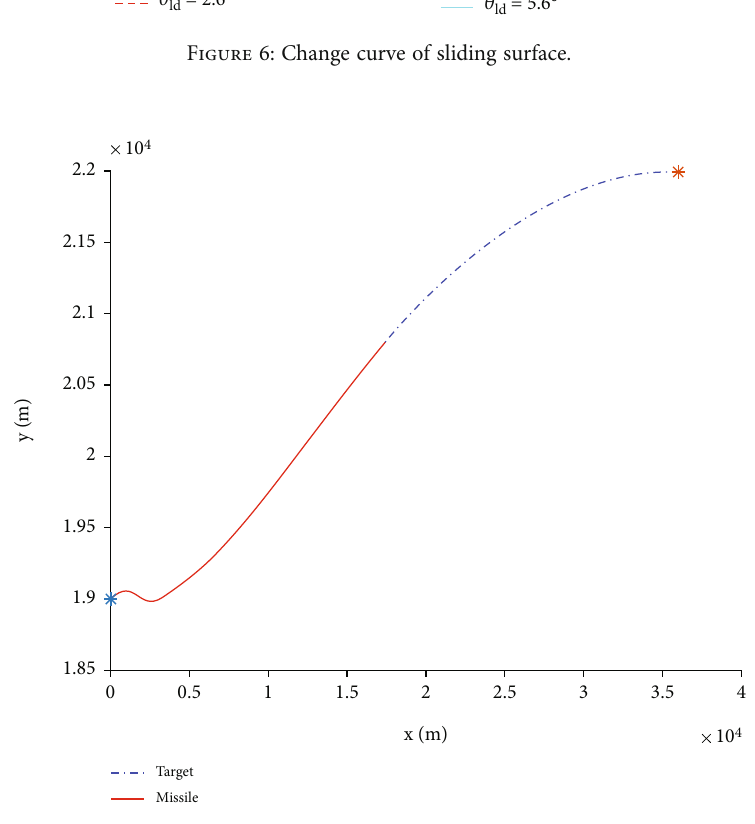
Figure 7: Trajectory